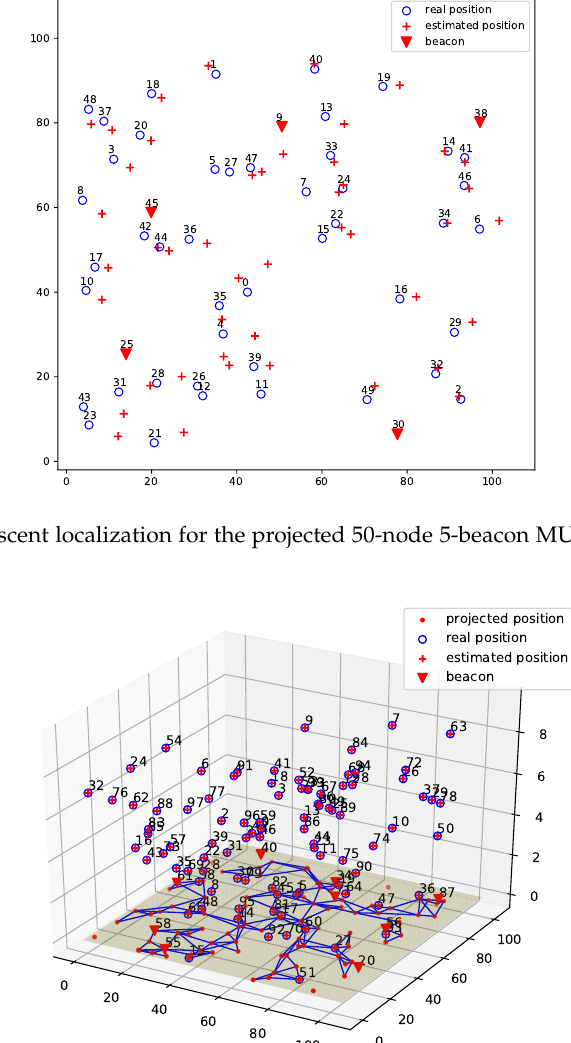
Figure 9. ProLo Localization for a 100-node 9-beacon 3D